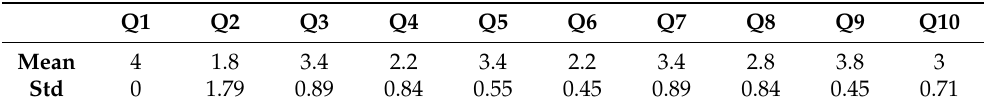
Table 4. SUS items’ mean score contribution (weighted: range 0–4): group with a low level of skill in MR. Q1 Q2 Q3